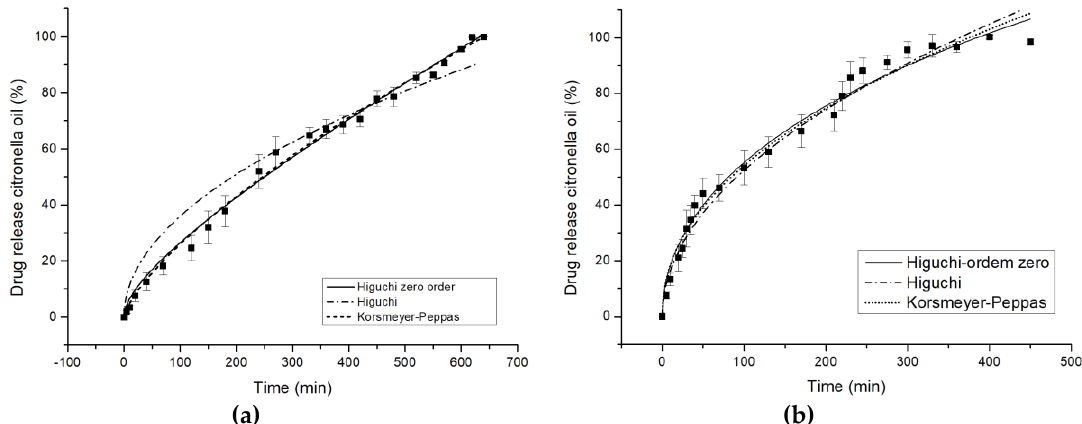
Figure 7. In vitro controlled release profiles of Higuchi zero order model, Higuchi model, and Korsmeyer-Peppas model in water at 37 °C for complex citronella essential oil applied on ( a ) cotton and ( b ) polyester.